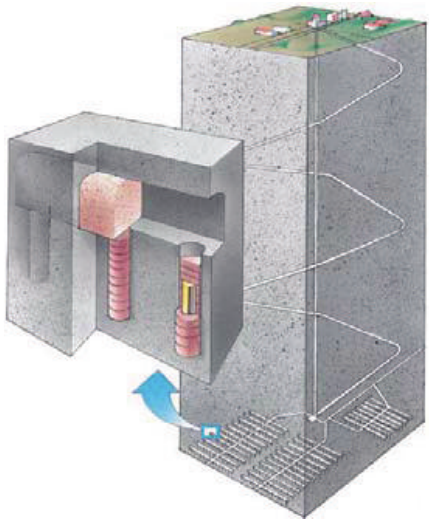
Figure 1: The KBS-3 method for spent nuclear